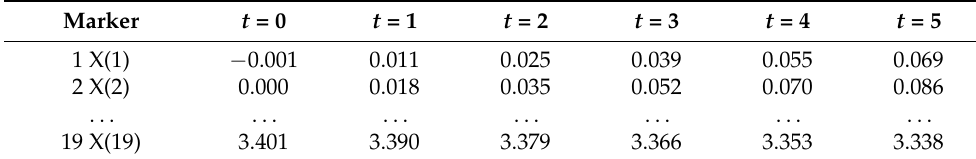
Figure 9. Original and reconstructed series of x coordinates of M 1 . ( i ) The reconstructed series ˜ X , i = 1, 2, . . . , 19 achieved by arithmetic averaging of N i Y V ( I 1 ) are represented in Table 9. Table 9. Reconstructed series of x coordinates of markers based on the signal